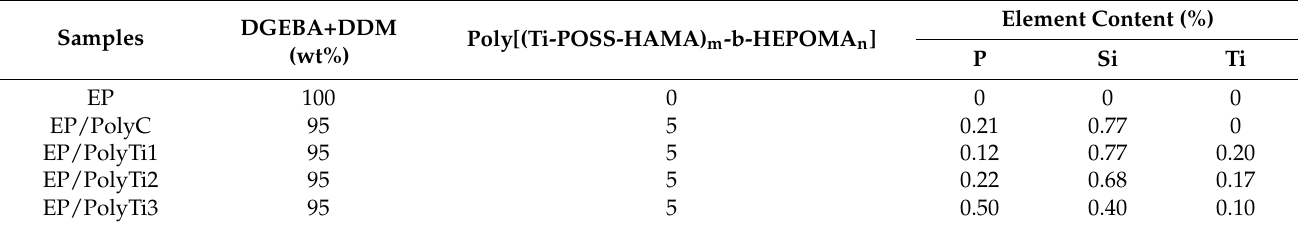
Table 1. The compositions of the EP/PolyTi composite